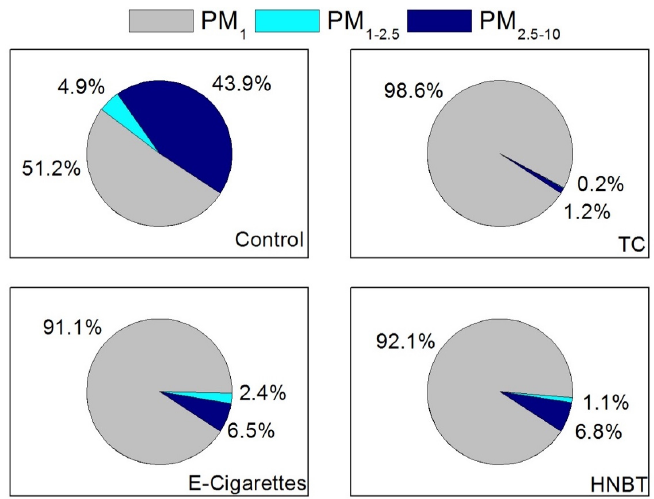
Figure 3. Contribution of each particle size fraction (PM 1 , PM 1–2.5 , PM 2.5–10 ) to the PM 10 in the home discriminated by NDS.